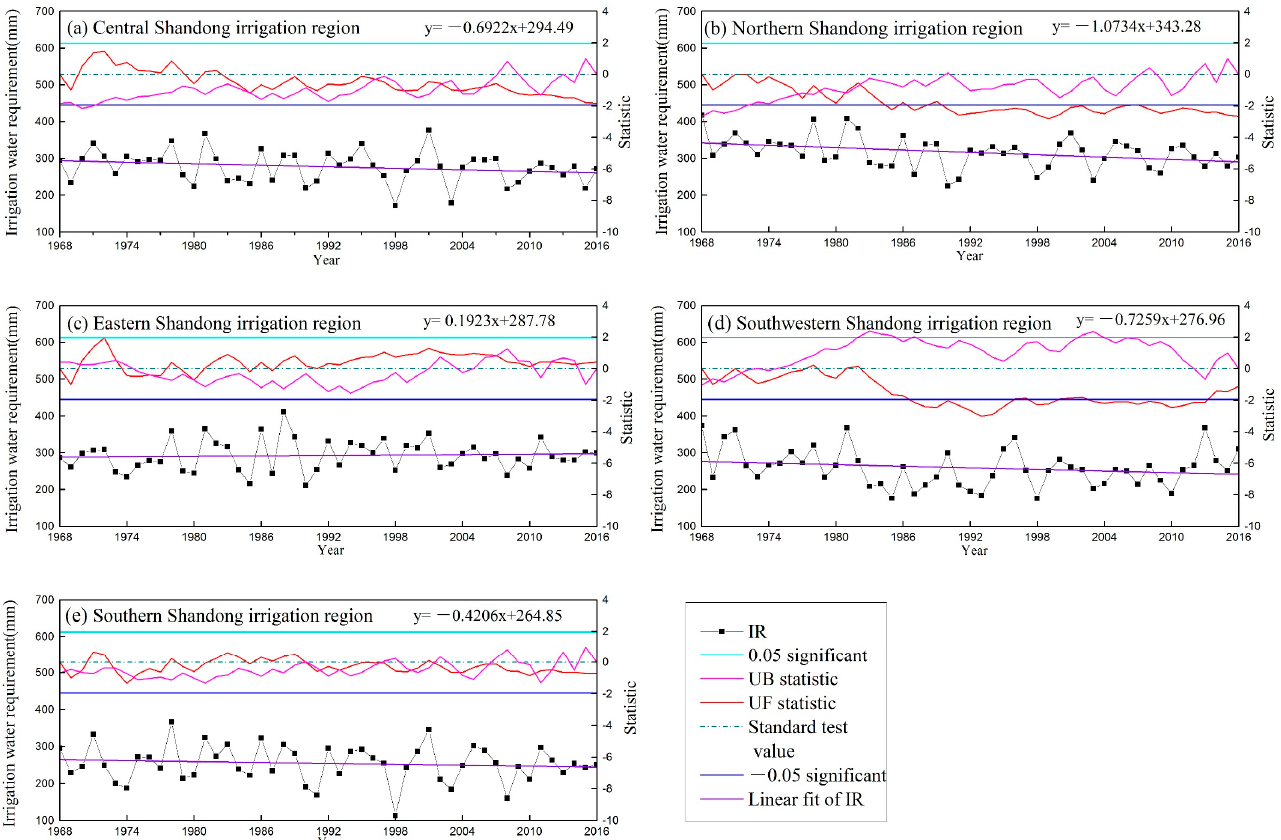
Figure 3. Variation trends of irrigation water requirements for winter wheat in different irrigation regions over the past 49 years. Note: ( a – e ) show the variation trends of winter wheat irrigation water requirements in the central Shandong irrigation region, northern Shandong irrigation region, eastern Shandong irrigation region, southwestern Shandong irrigation region, and southern Shandong irrigation region, respectively.